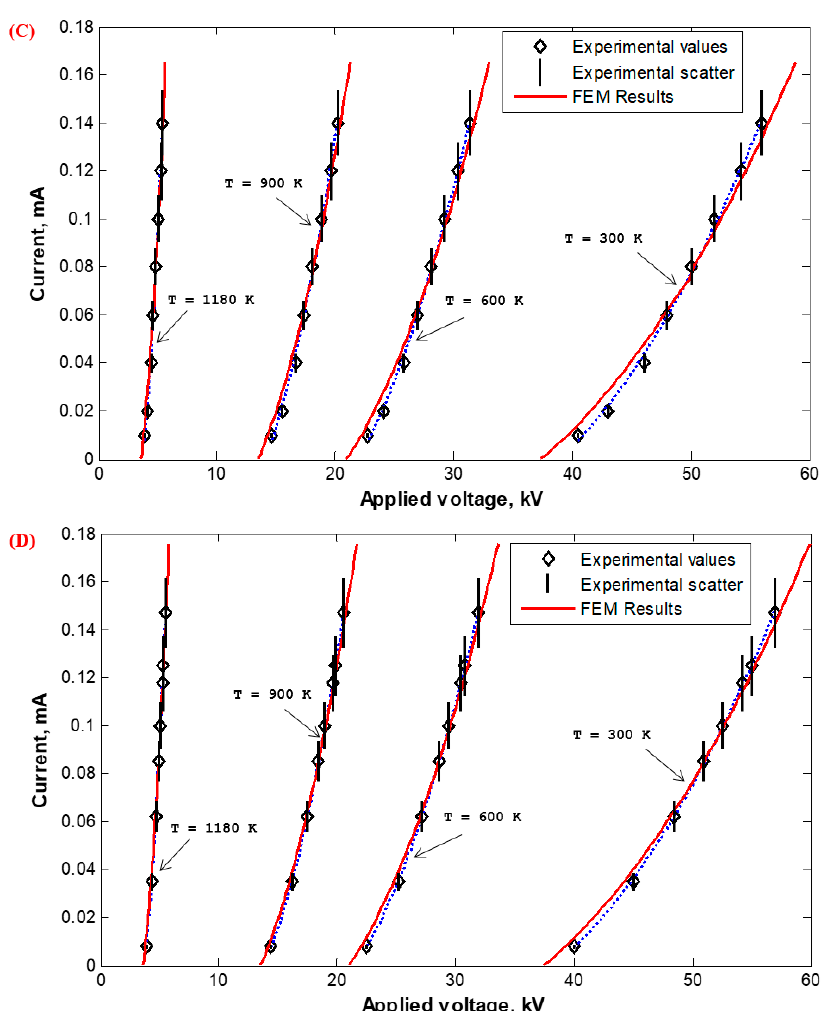
Figure 24. FEM molding and measured values experimentally for the I–V characteristics of WDESP ( r c = 0.935 mm) with high-temperature incoming gases for ( A ) single wire, ( B ) multi-discharge wire (three-wire), ( C ) multi-discharge wire (five-wire), and ( D ) multi-discharge wire (seven-wire).